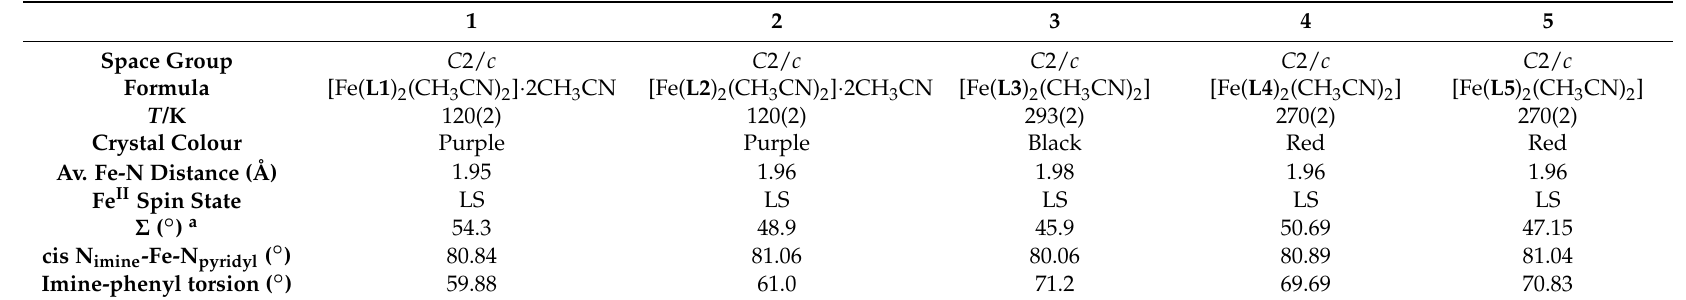
Table 1. Summary of structural parameters for complexes 1 – 5